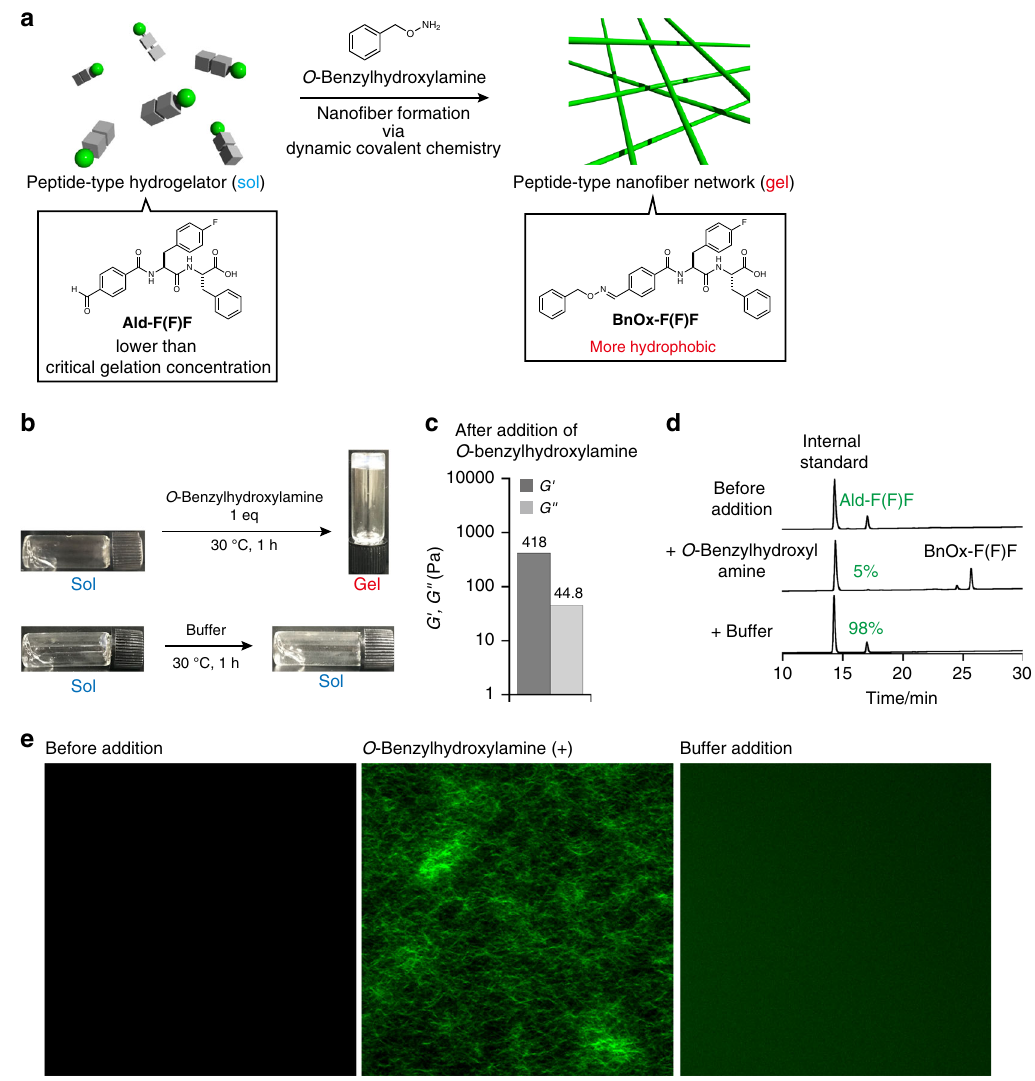
Fig. 2 Formation of peptide-type nano fi bers and hydrogel through an oxime formation reaction. a Schematic illustration of the nano fi ber formation (sol – gel transition) through oxime formation. b Macroscopic sol – gel transition of Ald-F(F)F upon (top) O -benzylhydroxylamine and (bottom) buffer treatment. c Rheological properties of the hydrogel. G ’ : storage shear modulus, G ’’ : loss shear modulus. Frequency: 10 rad/s, strain amplitude: 1%. d HPLC analysis of the formation rate of BnOx-F(F)F . Internal standard: fl uorescein. e High-resolution Airyscan CLSM images (left) before and 1 h after addition of (middle) O -benzylhydroxylamine or (right) buffer to Ald-F(F)F . Condition: [ Ald-F(F)F ] = 4.3 mM (0.20 wt%), [ O -benzylhydroxylamine] = 4.3 mM (1.0 eq), [ NP-Alexa647 ] = 4.0 µ M, 100 mM MES, pH